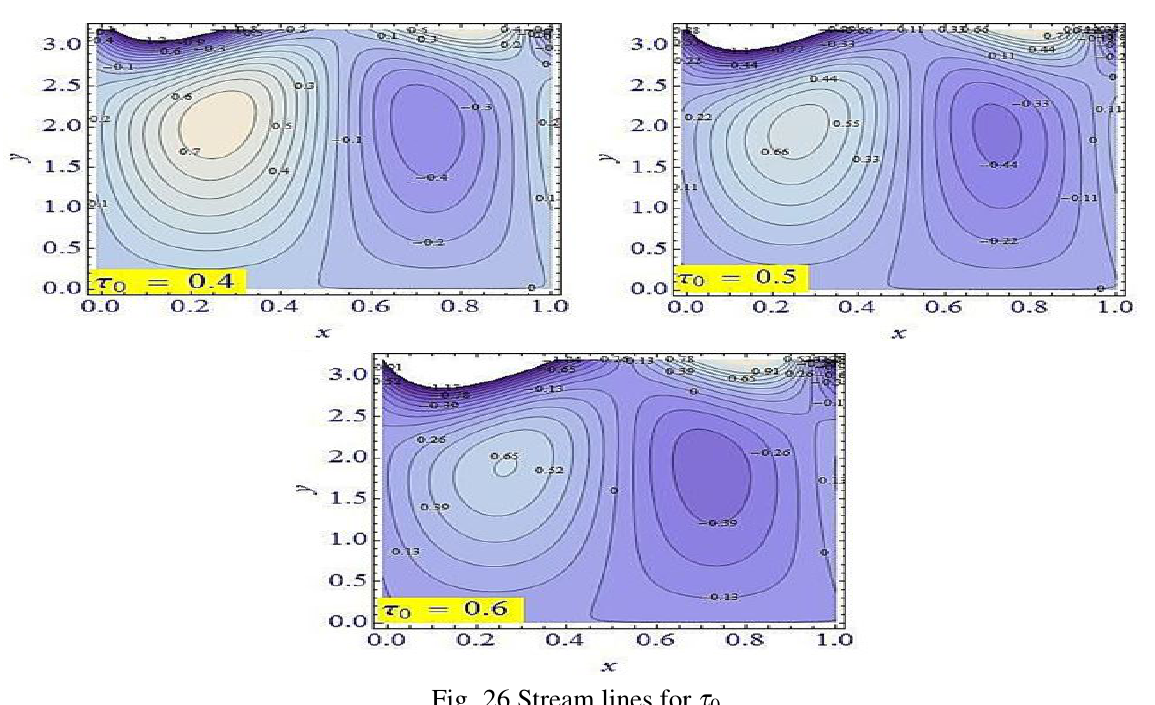
Fig. 26 Stream lines for τ 0